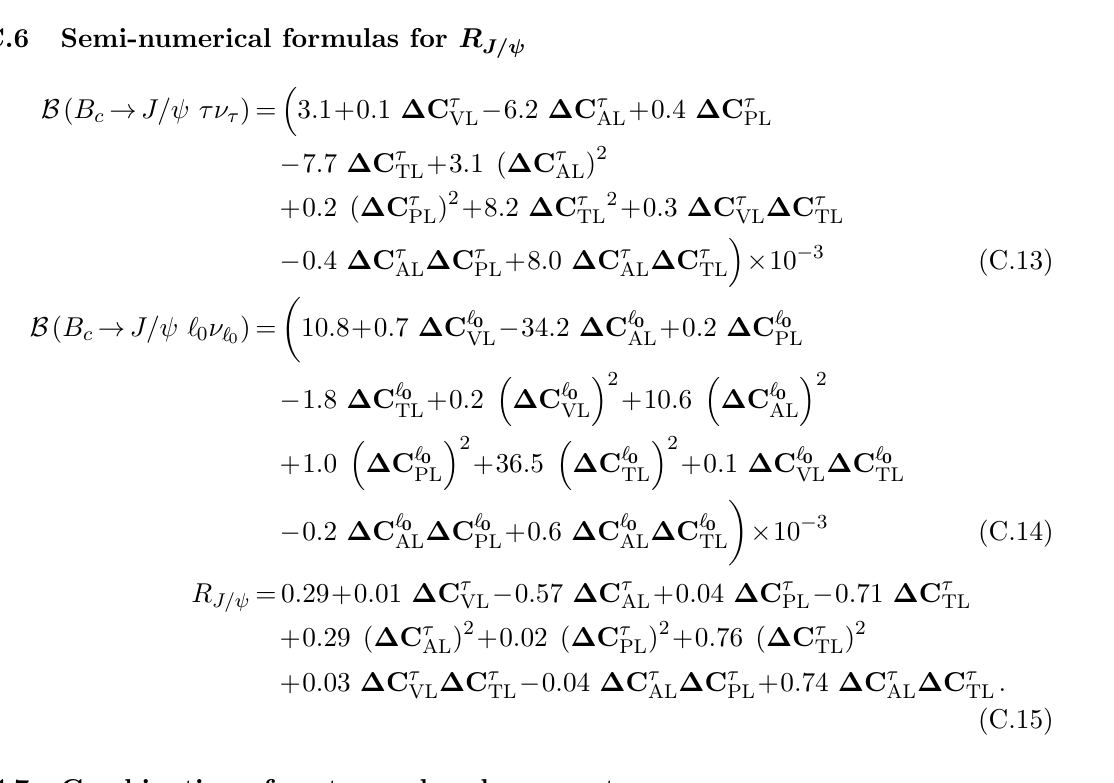
Figure 9 . The red and green shaded regions correspond to the values of C (cid:28) C (cid:28) (= (cid:0) C (cid:28) for the left panel and = C (cid:28) SL PL measurement of R D and R D (cid:3) within 1 (cid:27)